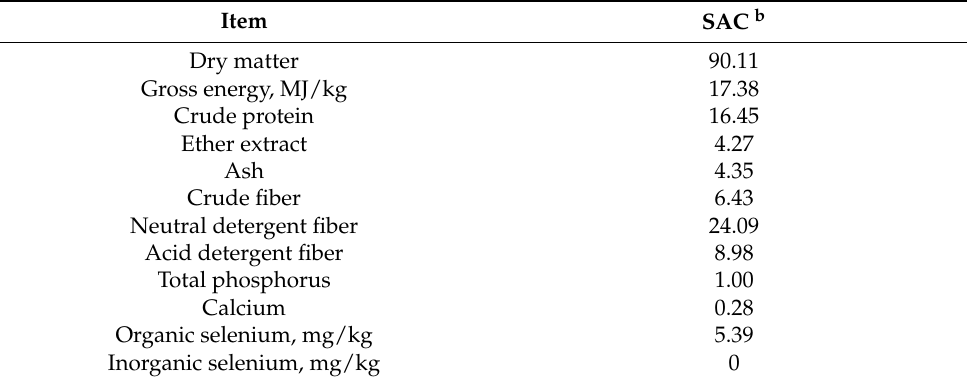
Table 1. Analyzed nutrient content of Selenium Auricularia cornea culture (%, as-fed basis) a .